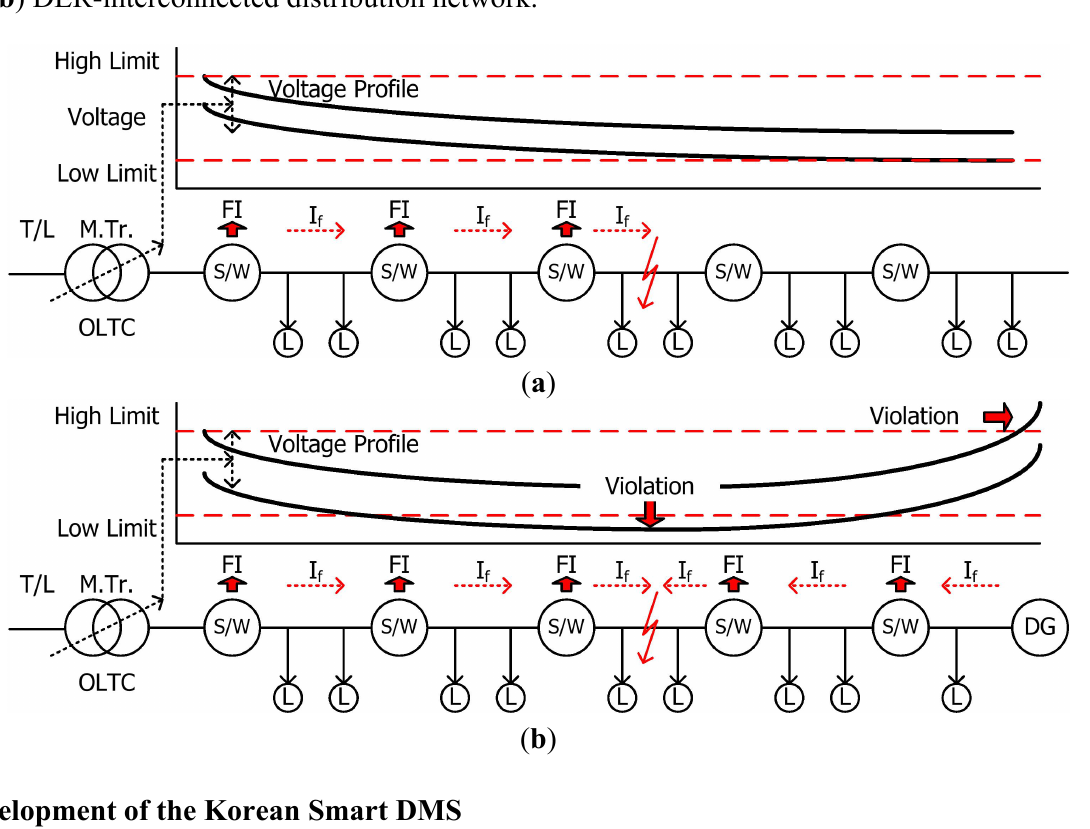
Figure 1. Challenges of TDAS: ( a ) non-DER interconnected distribution network and ( b ) DER-interconnected distribution